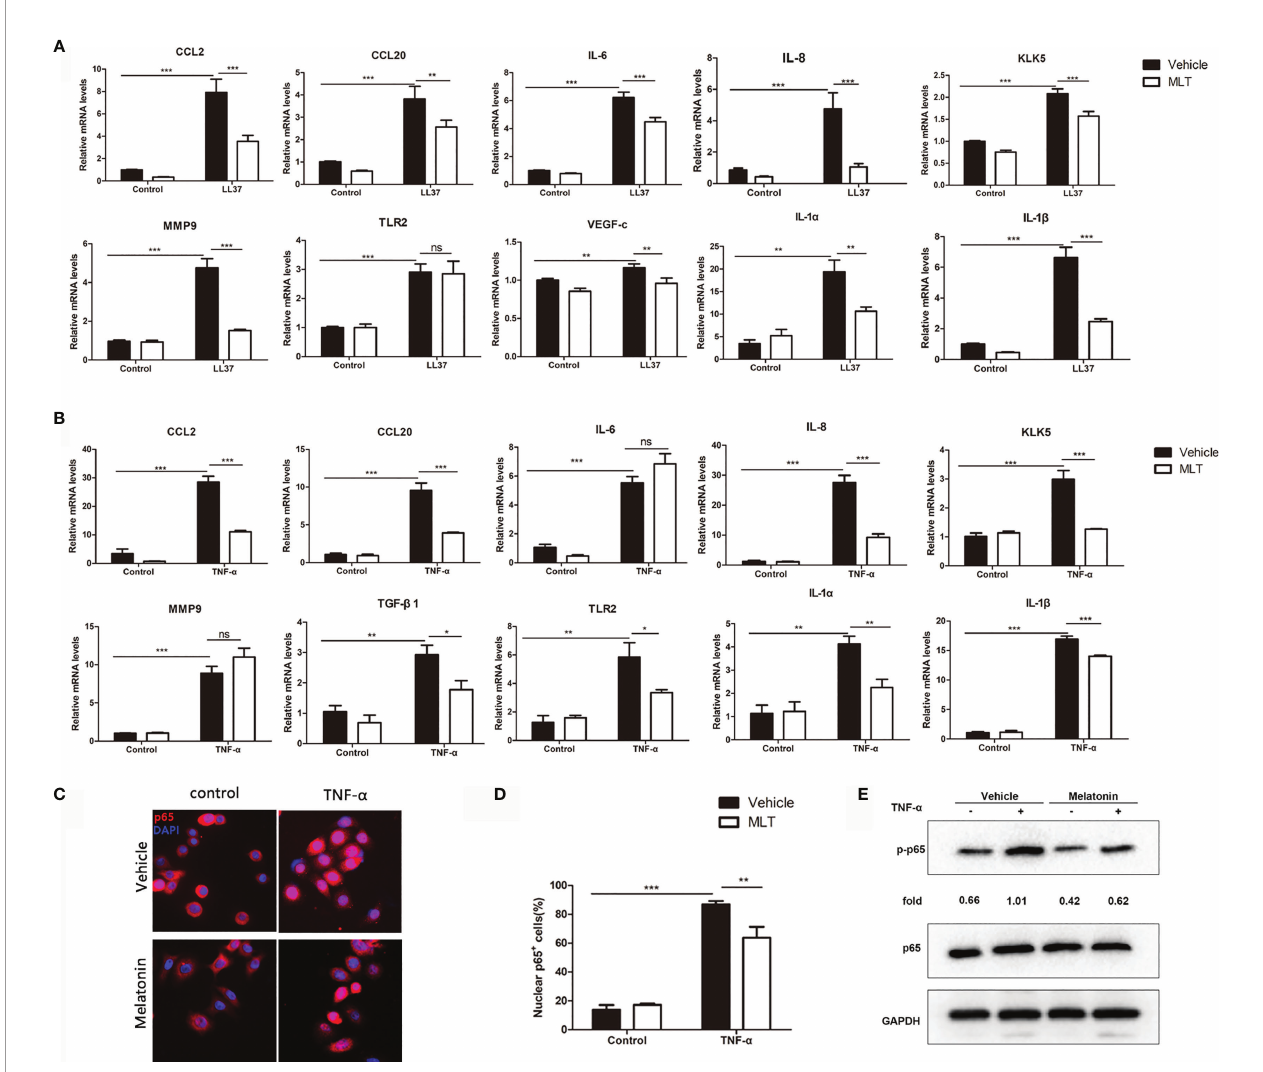
FIGURE 7 | MLT reduced the secretion of in fl ammatory factors from keratinocyte. qPCR analysis revealed the effects of MLT on the expression of in fl ammatory cytokines in LL37-treated HaCaT cells (A) and TNF- a -treated HaCaT cells (B) . (C) Immuno fl uorescence analysis revealed the TNF- a -induced p65 translocation. (D) Percentage of p65-positive cells in the nucleus. (E) Immunoblotting of p-p65 and p65 HaCaT cells. All results are representative of at least t independent experiments. Data expressed as individual values with mean ± SEM. * P < 0.05, ** P < 0.01, *** P < 0.001. A two-tailed unpaired Student ’ s t -test was